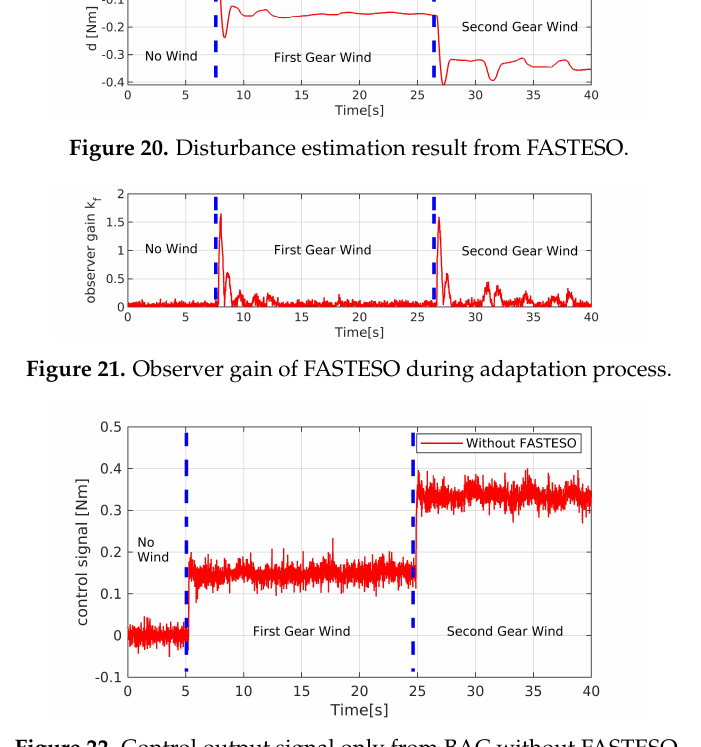
Figure 22. Control output signal only from BAC without